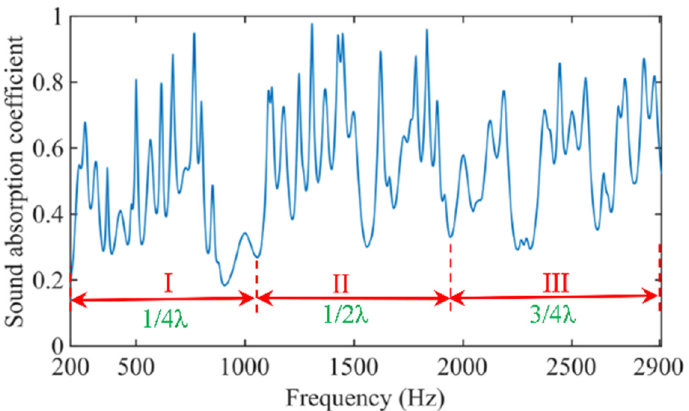
Figure 3. Distribution of the sound absorption coefficients of the MSC-AM in theory.